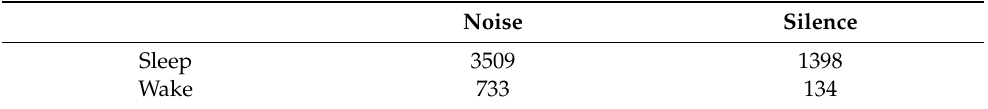
Table 4. Number of 15-s actigraphy epochs classified as sleep or wake in the presence of noise or silence (last 90 min).